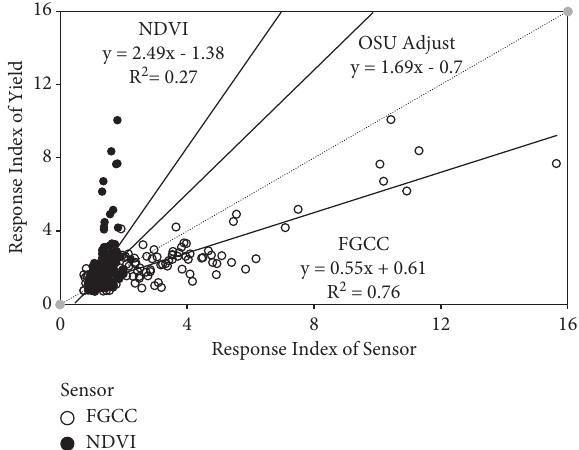
Figure 3: Relationship between RI (response index) of each sensor (NDVI or FGCC) and yield. RI refers to the ratio between the value (either yield or sensor value) from the N-Rich Strip and the farmer practice (FP). The x -axis refers to the RI Sensor , and the y -axis refers to the RI Yield . The gray dashed line represents the 1:1 line, or where the RI Sensor � RI Yield . The thick black line describes the current RI adjustment equation utilized by Oklahoma State University. To develop a prediction model, RI Sensor undergoes a transformation in order to make the relationship of RI Yield :RI Sensor closer to